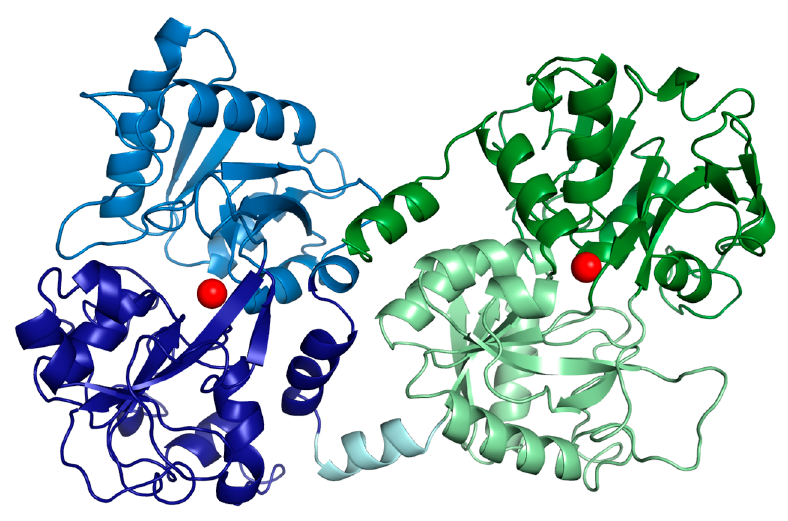
Figure 1. Cartoon representation of bovine lactoferrin. N-lobe is blue (N1 pale blue and N2 dark blue) and C-lobe is green (C1 dark green and C2 pale green). The hinge helix is represented in a pale cyan. Iron ions are reported as red spheres.